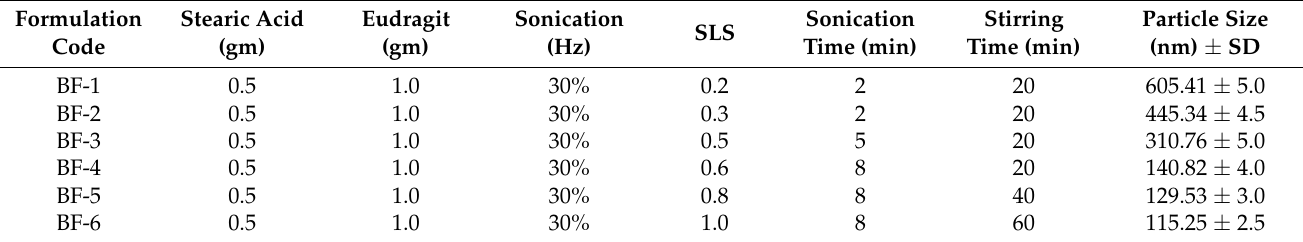
Table 3. Process and experimental conditions for preparation of blanks nanoparticles.